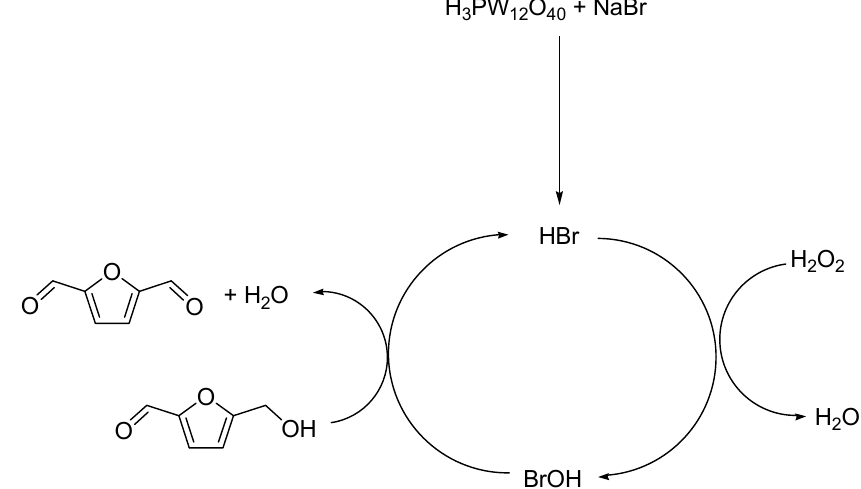
Scheme 1. Proposed mechanism of HMF oxidation to DFF.